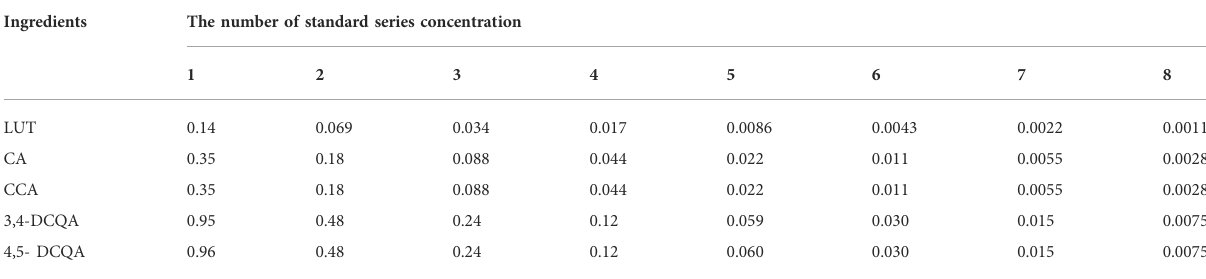
TABLE 1 The standard series concentration of fi ve ingredients including LUT, CA, CCA, 3,4-DCQA, and 4,5-DCQA ( μ mol/L).